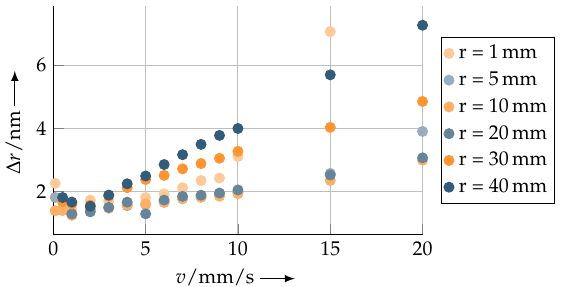
Figure 12. Deviation of circle movement of a given circle trajectory with radii between 1mm and 40mm at different velocities (0.1mm/s–20mm/s). The circular movement was carried out with 5 revolutions in each